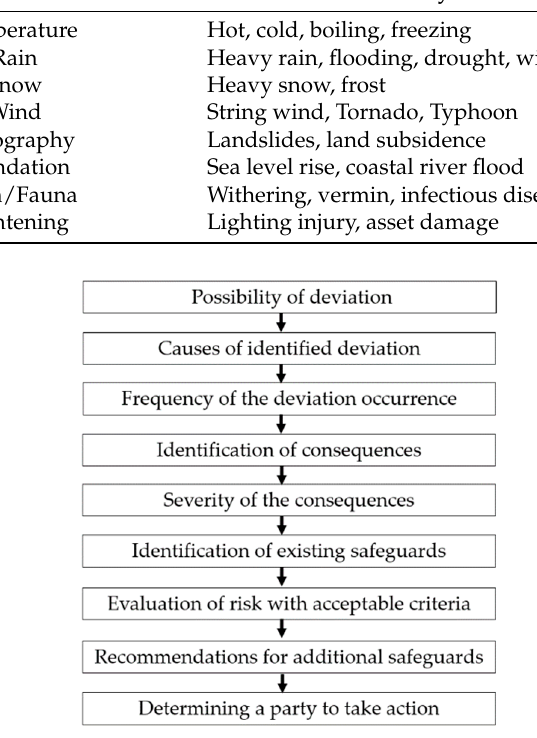
Figure 1. The steps used in hazard identification from derived deviations (adapted from [27]).